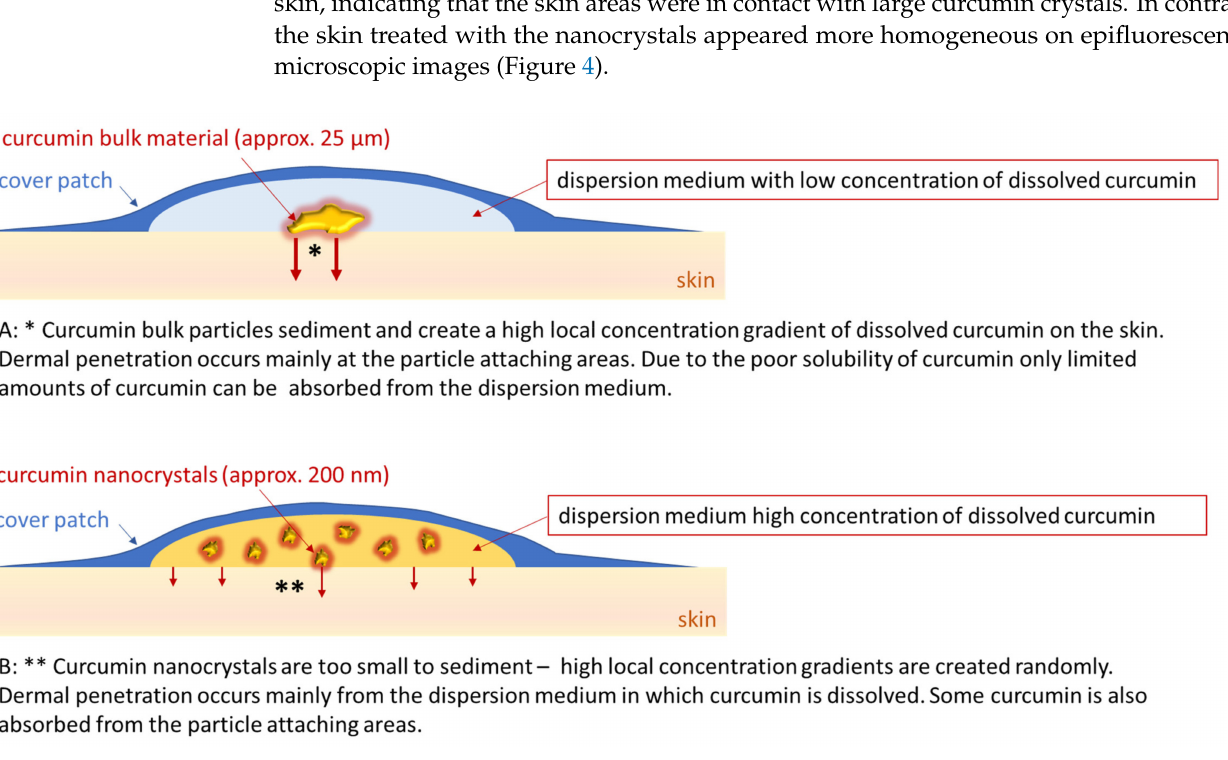
Figure 5. Principle of dermal penetration of curcumin from curcumin bulk suspensions ( A ) and curcumin nanocrystals ( B